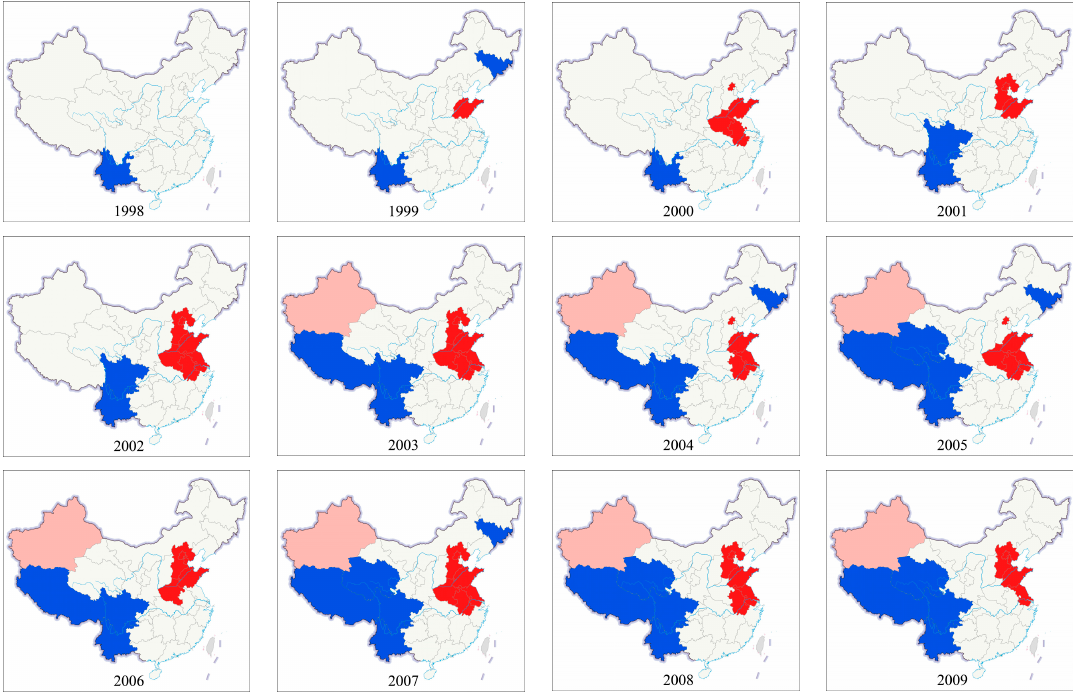
Figure 9. Global Moran’s I of PM 2.5 concentration for 31 provinces, 1998–2016. Notes: a, b represent coefficients significant at the 1%, 5% levels,